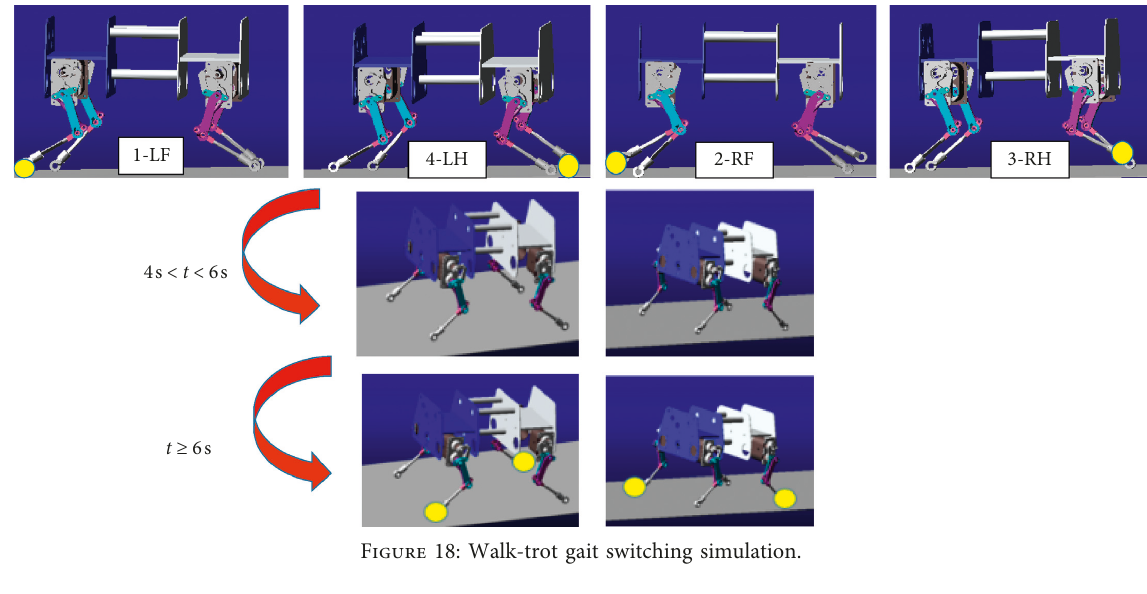
Figure 18: Walk-trot gait switching simulation.